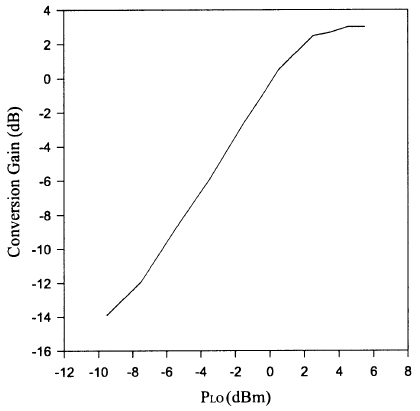
FIGURE 16 Conversion gain vs. the P LO